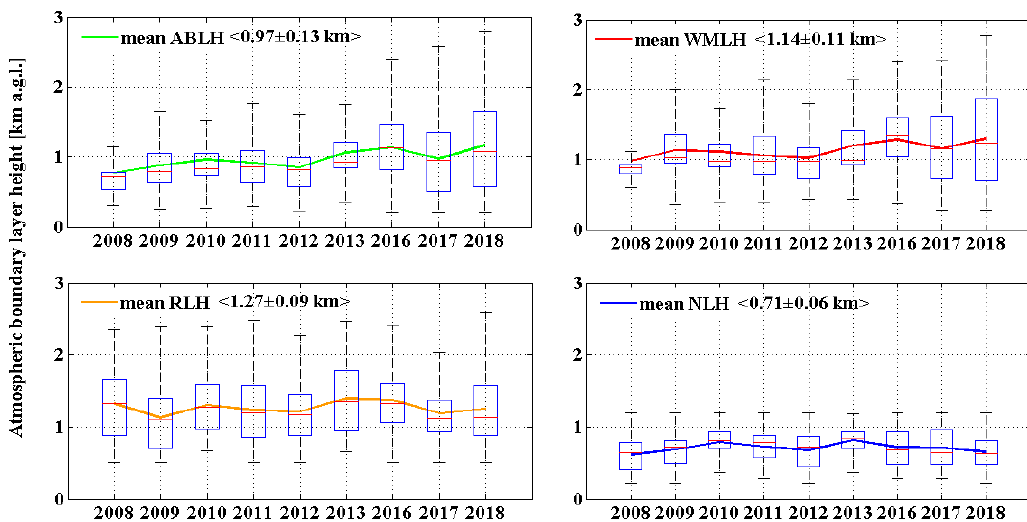
Figure 10. Box plot showing the annual mean ABLH values (solid lines) calculated using the WCT method applied to the PollyXT lidar and the CHM15k ceilometer signals. Calculations in clear-sky conditions over Warsaw from 2008 to 2018. The boxes show the median, 25th, and 75th percentiles. In green, the annual mean ABLH for all derived atmospheric boundary layer (ABL, i.e., the mean of RL or NL, TL, and WML); in red, for the well-mixed layer height (WMLH); in blue, for the nocturnal layer height (NLH); in orange, for the residual layer height (RLH). The lack of data for 2014 and 2015 is due to their underrepresentation for the annual mean. Merging and homogenization were applied to the lidar data from November 2013 to December 2018.